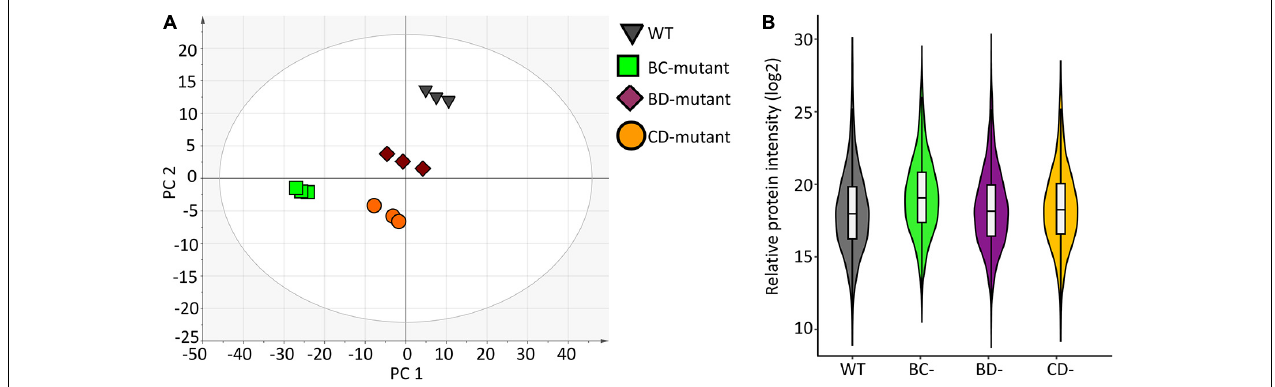
FIGURE 2 | Data structure and variance within the proteome measurement of WT and double-mutant lines. (A) PCA scores plot shows separation due to protein abundance variation for WT and double-mutant lines. Each symbol represents one replicate from a barley line. (B) Violin plot depicting protein variance from wild-type (WT) and three double mutant lines ( n =